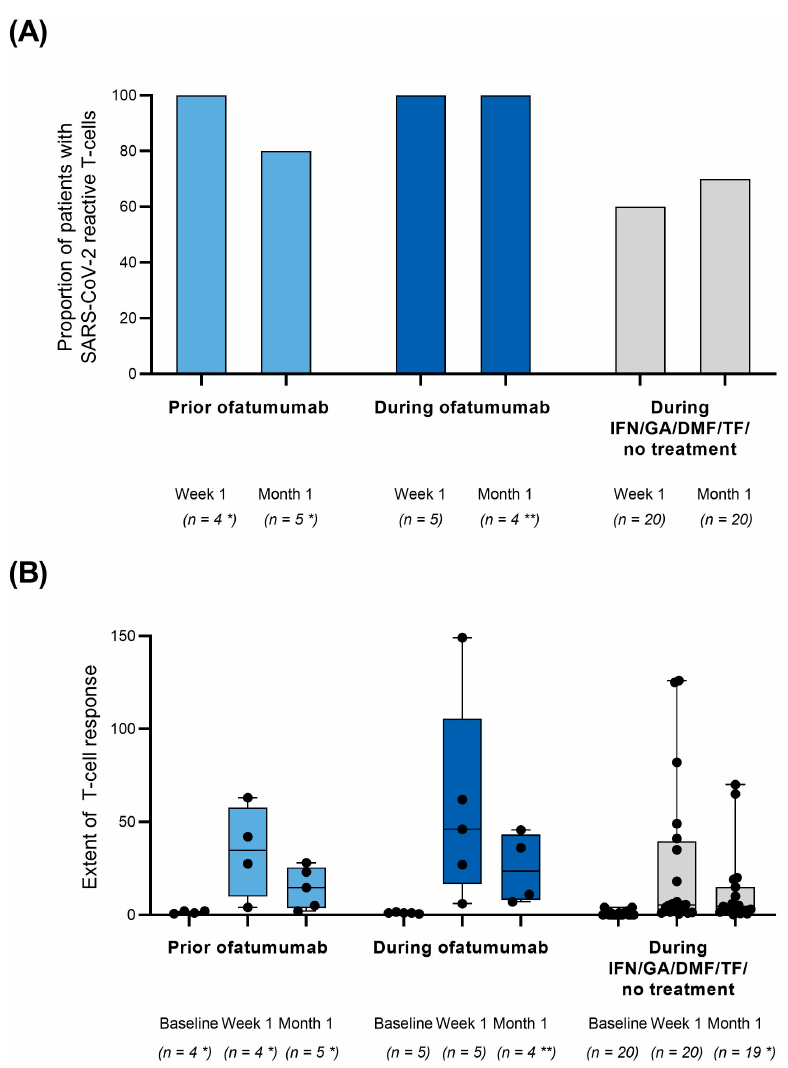
Figure 1. ( A ) SARS-CoV-2 specific T-cell responses after initial vaccination prior to or during ofatu- mumab treatment. ( B ) ELISpot-based quantification of T-cell reactivity after initial vaccination prior or during ofatumumab treatment by calculation of IFN- γ stimulation indices towards SARS-CoV-2 presented as mean (SD). * One patient in cohort 1 discontinued the study and only participated in a visit at month 1. For remaining patients, T-cell response could not be assessed due to technical problems. ** For one patient at month 1, visit could not be performed due to COVID-19 infection. DMF: dimethyl fumarate; GA: glatiramer acetate, IFN: interferon-beta; n: number of patients with assessments; TF: teriflunomide. Boxplots: min/max, horizontal line = mean. Black dots = individual values. All patients in cohort 1 reached seroconversion for SARS-CoV-2 neutralizing antibodies at week 1 and month 1 after initial vaccination. In cohort 2, seroconversion was reached by 40.0% at week 1 and by 25.0% at month 1, while in cohort 3, the seroconversion rates for neutralizing antibodies were 90% at week 1 and 95% at month 1. All patients showed an increase in neutralizing antibody titers as soon as one week after full initial vaccination, although titers remained lower in cohort 2 (Figure 2A). SARS-CoV-2 serum